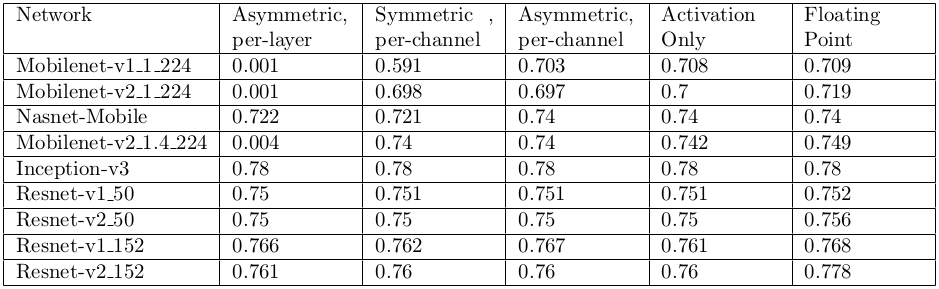
Table from the paper: Quantizing deep convolutional networks for efficient inference: A whitepaper
Table text:
Network
Asymmetric,
per-layer
Symmetric ,
per-channel
Asymmetric,
per-channel
Activation
Only
Floating
Point
Mobilenet-v11224
0.001
0.591
0.703
0.708
0.709
Mobilenet-v21224
0.001
0.698
0.697
0.7
0.719
Nasnet-Mobile
0.722
0.721
0.74
0.74
0.74
Mobilenet-v21.4224
0.004
0.74
0.74
0.742
0.749
Inception-v3
0.78
0.78
0.78
0.78
0.78
Resnet-v150
0.75
0.751
0.751
0.751
0.752
Resnet-v250
0.75
0.75
0.75
0.75
0.756
Resnet-v1152
0.766
0.762
0.767
0.761
0.768
Resnet-v2152
0.761
0.76
0.76
0.76
0.778